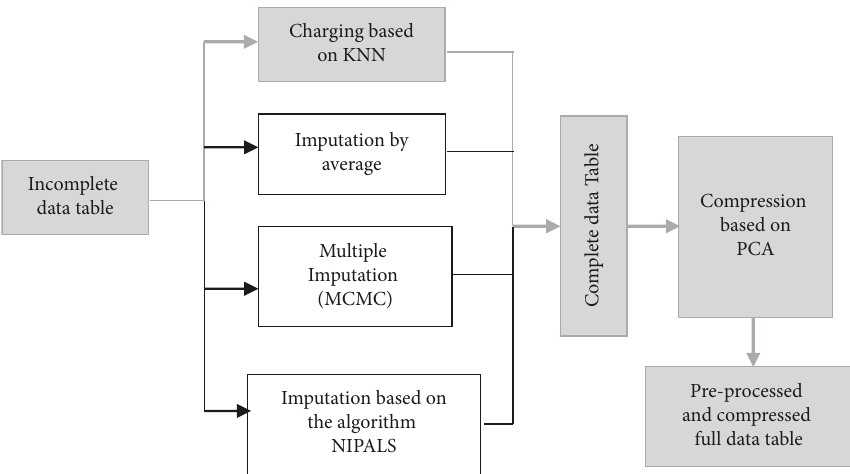
Figure 1: Proposed preprocessing